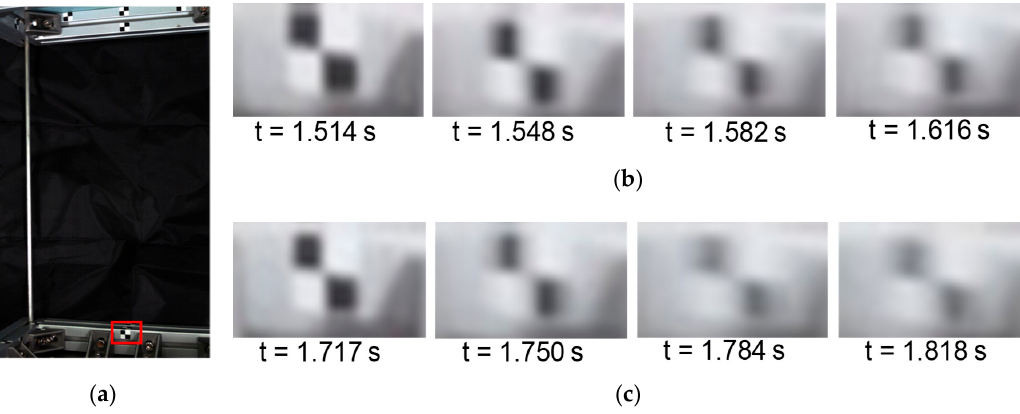
Figure 9. Blurring of images due to movement. ( a ) Tracking point. ( b ) Tracking point images blurring due to movement ( t = 1.514 to 1.616 s). ( c ) Tracking point images blurring due to movement ( t = 1.717 to 1.818